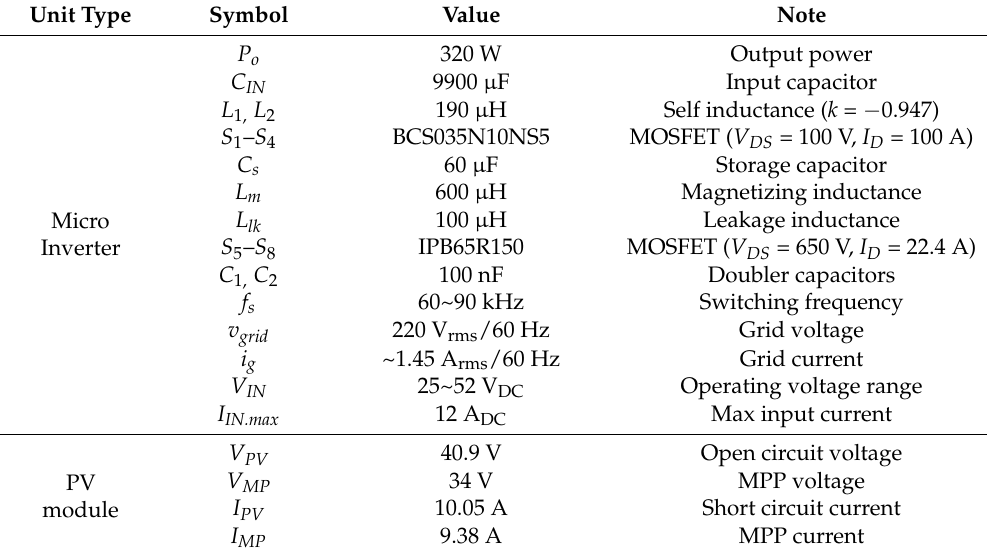
Figure 11. Photograph of the proposed micro-inverter. Table 2. Hardware specifications and circuit parameters .